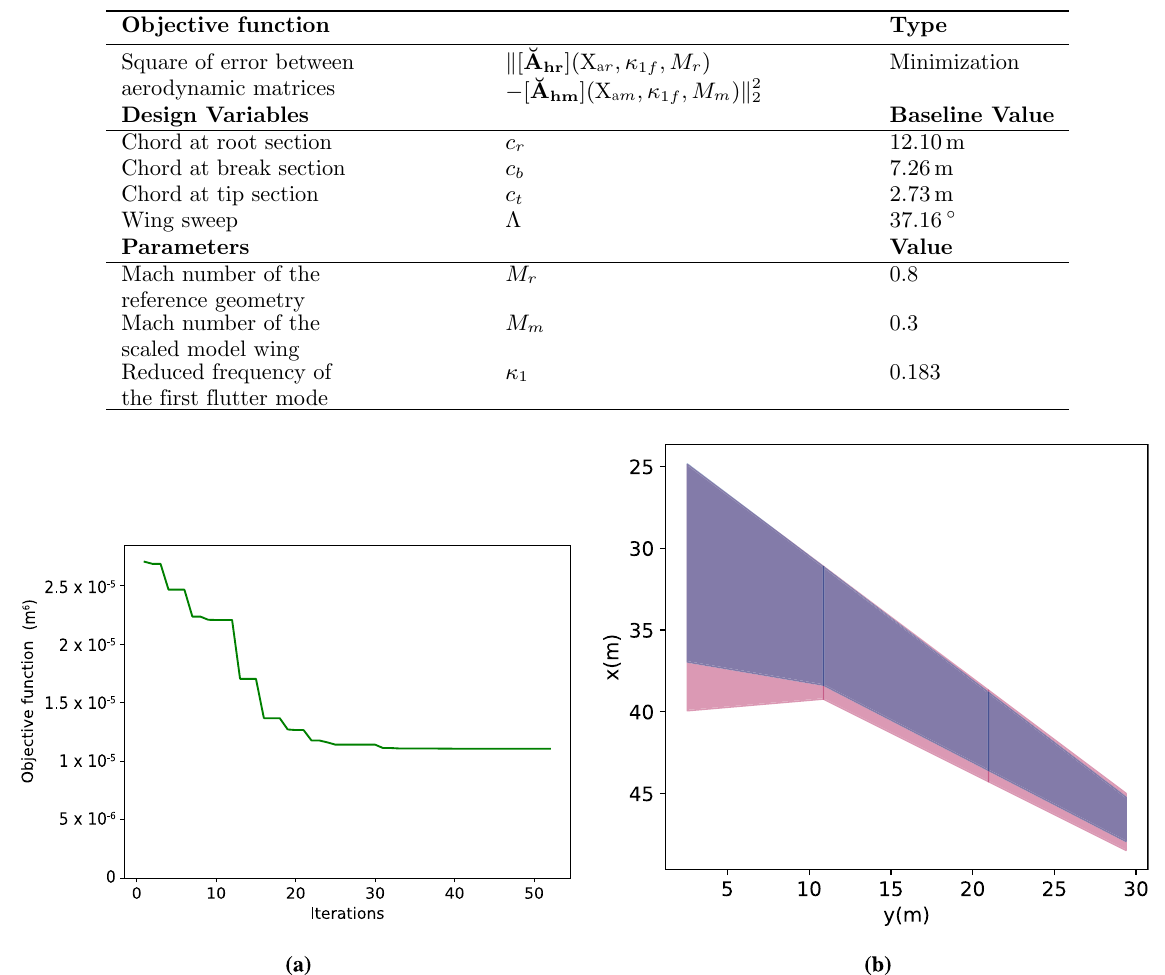
Fig. 4. Evolution of the objective function (24) with the number of optimization iterations (a). Optimized planform (red) and baseline (blue)